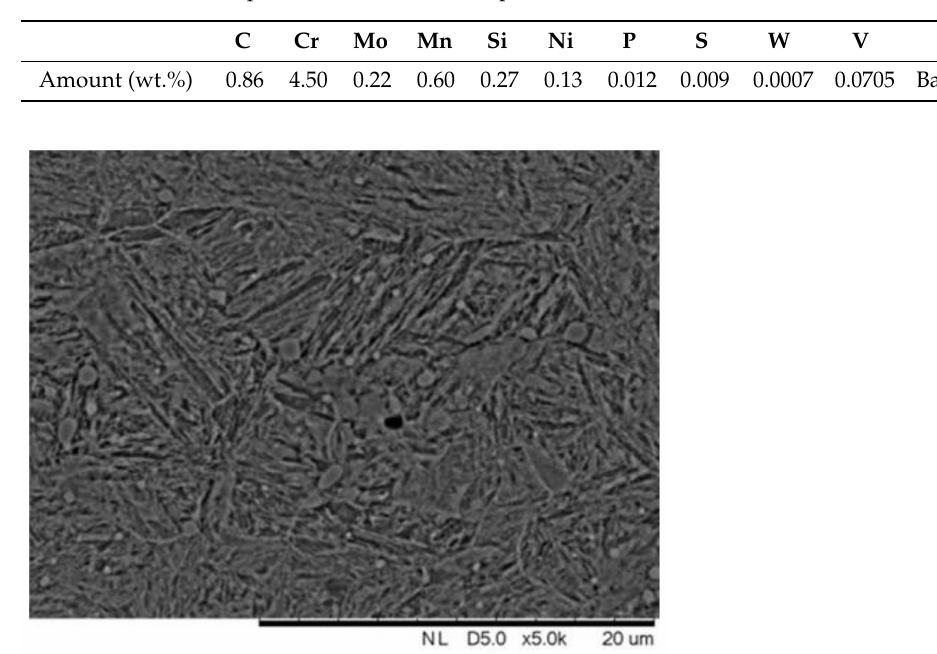
Table 1. Chemical composition of the tool steel specimens.